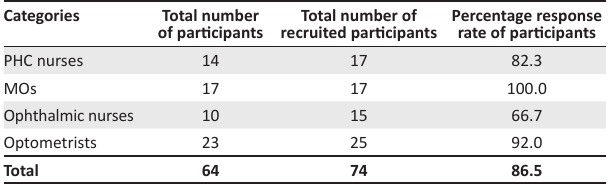
FIG URE 1: Diabetic patient flow diagram. TABLE 1: Categories and number of participants from clinics and